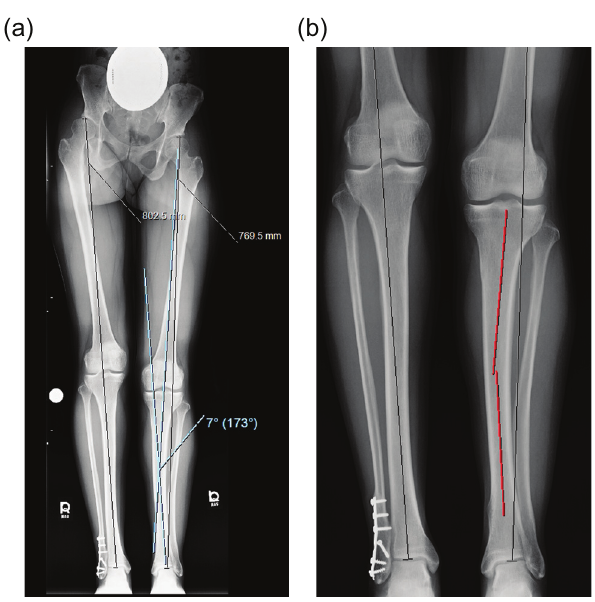
Figure 10. (a) The 51 inch standing film shows a diaphyseal valgus deformity and limb length discrepancy. (b) The path of the ILN is planned with the osteotomy site at the intersection of the red lines.